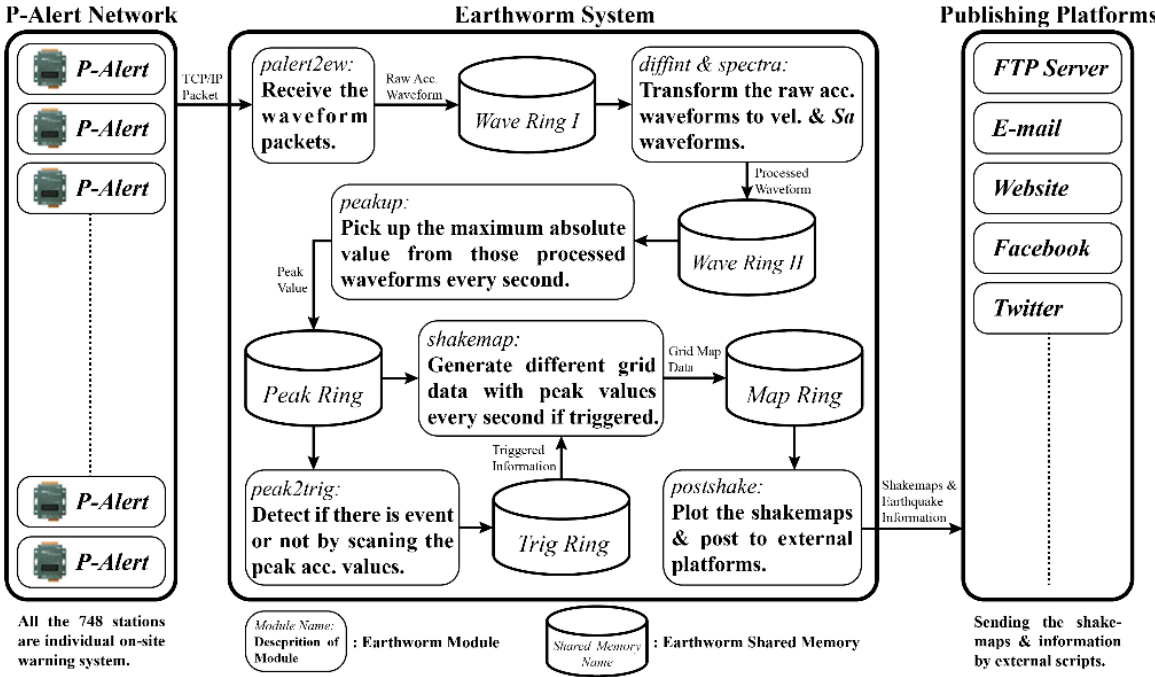
Figure 3. A flowchart showing the different steps and modules involved in plotting the different shakemaps (PGA, PGV, Intensity, and S a ).